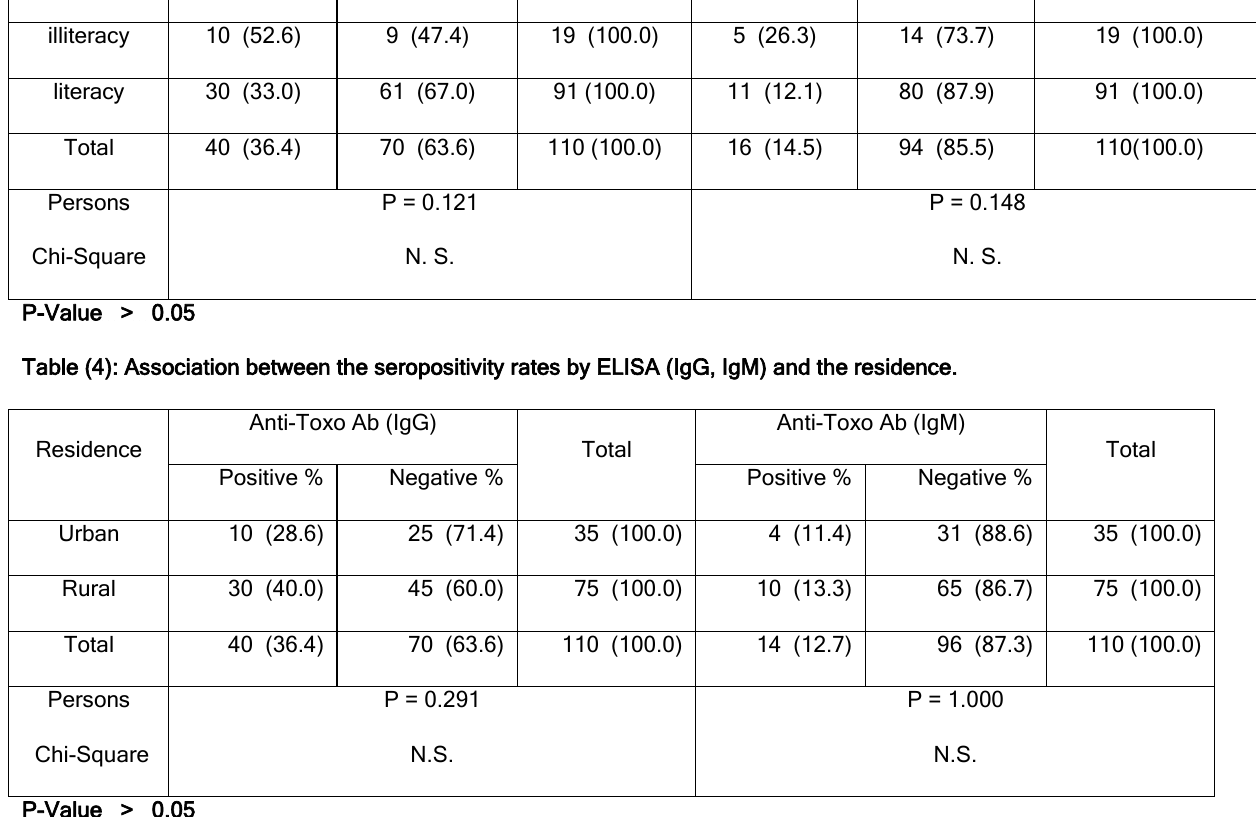
Table (3): Association between IgG anti-Toxoplasma Ab and IgM anti-Toxoplasma Ab with the level of Education. Level of